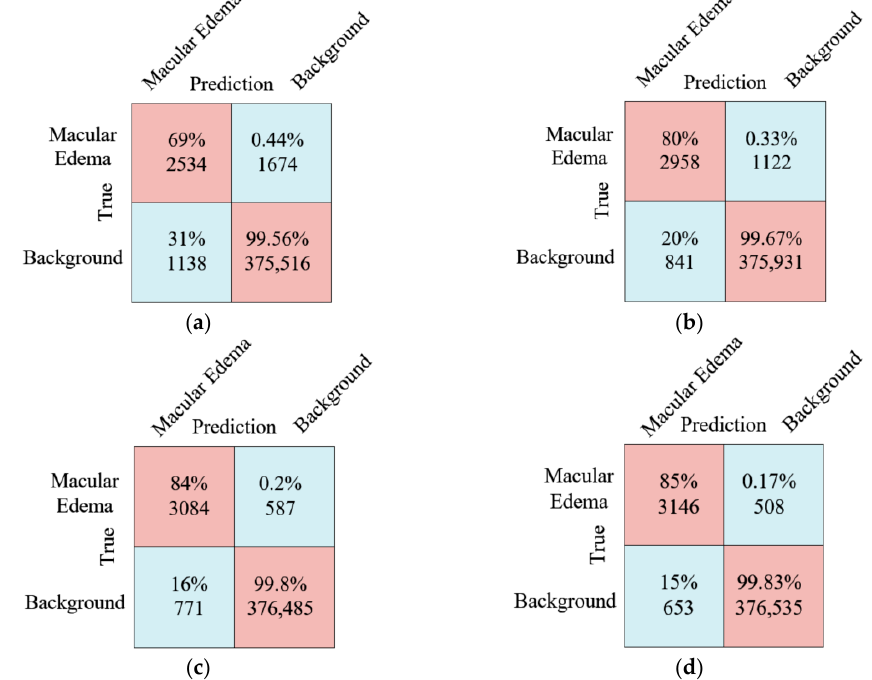
Figure 5. Confusion matrix comparison diagram ( a ) FCN; ( b ) TransUNet; ( c ) Res-UNet++; ( d ) The proposed method.